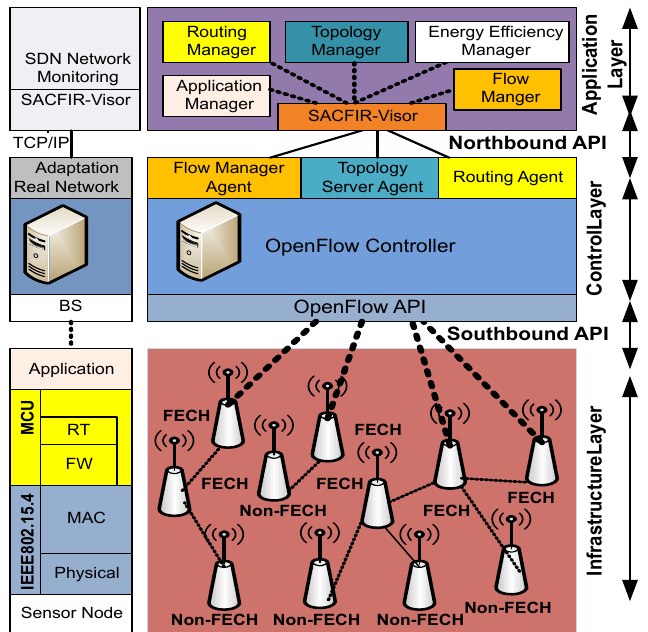
Figure 2. Heterogeneous hybrid architecture of SDN-enabled Iteratively Reconfigurable WSNs